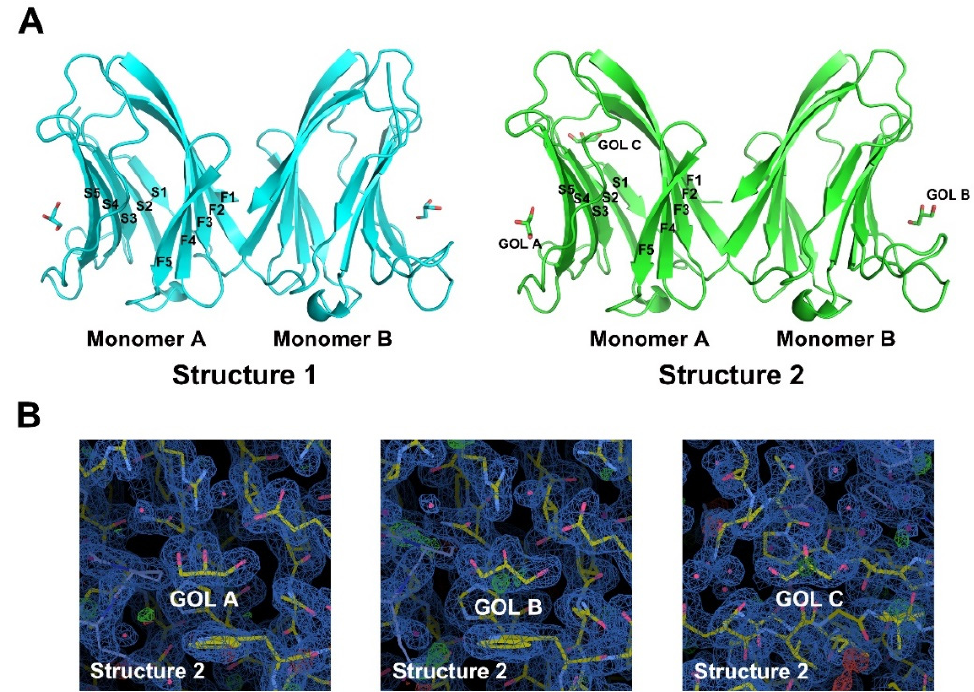
Figure 3. Structure of Gal-7 in complex with glycerol. ( A ) Gal-7 was crystallized as a dimer. In structure 1, each monomer can bind one glycerol; however, monomer A of structure 2 can bind two glycerols. ( B ) The electron density for the three glycerol molecules showed them to be different in their binding pocket. The 2| Fo |-| Fc | map contoured at 1.0 σ is shown in blue. Differences in C α RMSD values compared to Gal-7 structures (PDB: 1BKZ) are rela- tively small (RMSD 7XAC versus 1BKZ = 0.584 Å, RMSD 7XBL versus 1BKZ = 0.343 Å, RMSD 7XBL versus 7XAC = 0.685 Å). This indicates that the binding of glycerol hardly changes the overall structure of Gal-7, but changes may occur in certain